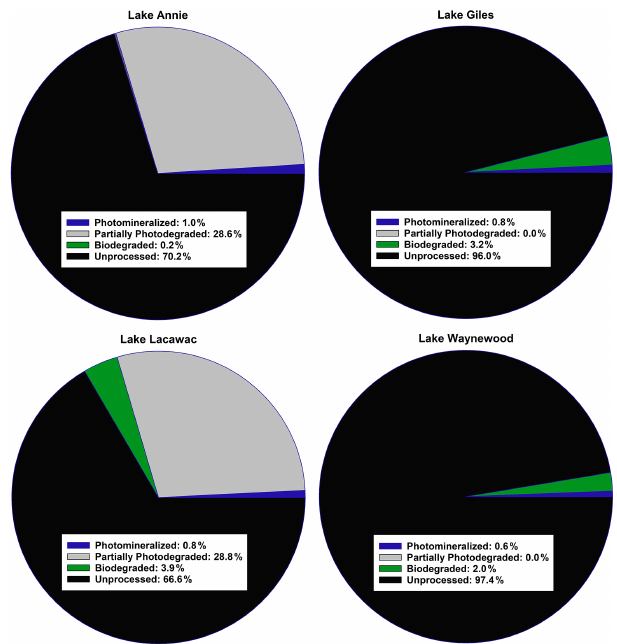
Figure 2. A summary of the average fate of carbon in the ground- water samples from our study lakes (see Sect. 2 for an explanation of the calculations). All terms were converted to a carbon basis. Photomineralized describes the amount of carbon completely min- eralized to CO 2 by sunlight. Partially photodegraded describes the amount of carbon processed by sunlight minus the amount pho- tomineralized. Biodegraded describes the amount of carbon lost through biodegradation. Unprocessed carbon describes the remain- ing carbon that was not processed by photodegradation or biodegra- dation.